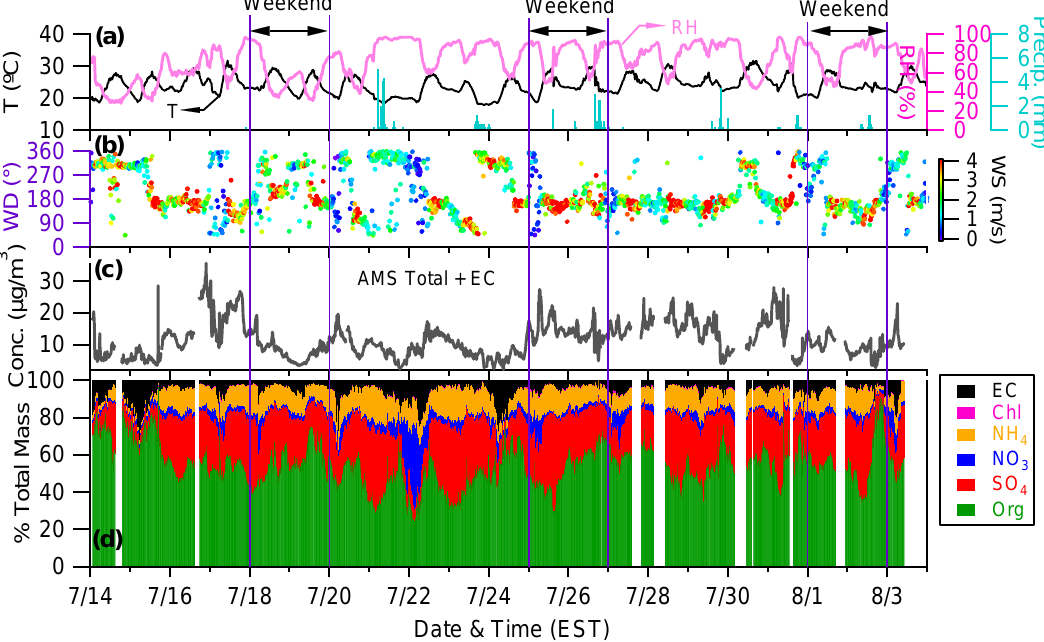
Fig. 2. Time series of (a) relative humidity (RH), temperature (T), and hourly precipitation (Precip), (b) wind direction (WD) colored by wind speed (WS), (c) mass concentration of AMS total+ EC, and (d) mass fractions of chemical species in PM 1 . ∼ 0.35 µg m − 3 from 08:00 a.m. to 14:00 p.m., is much lower than the observed ∼ 1 µg m − 3 increase of sulfate (Fig. 4a),